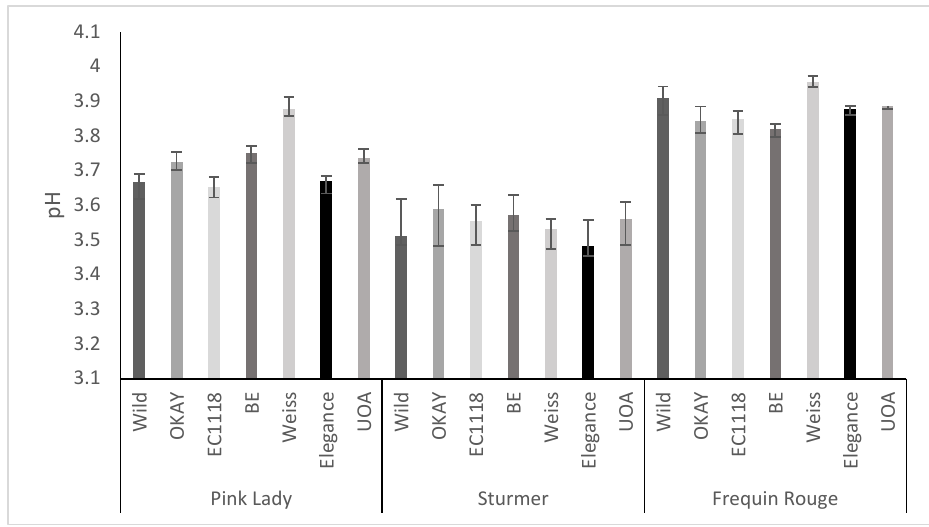
Figure 3. pH of cider made by each yeast strain in 2019, for all three apple varieties. In 2019, for both juice and cider, ‘Frequin Rouge’ had the highest pH, followed by ‘Pink Lady’ and then ‘Sturmer’; this trend was evident for all yeast strains. The difference was driven by varietal interactions with certain strains. For example, cider made with the variety ‘Pink Lady’ had a significantly greater pH when fermented using the ‘Weiss’ strain compared to when fermented using the ‘Elegance’ strain, but this interaction was not seen for other apple varieties. This may indicate to cider makers that yeast strain will not sig ‐ nificantly alter the original range of the juice pH when looking at single varieties.